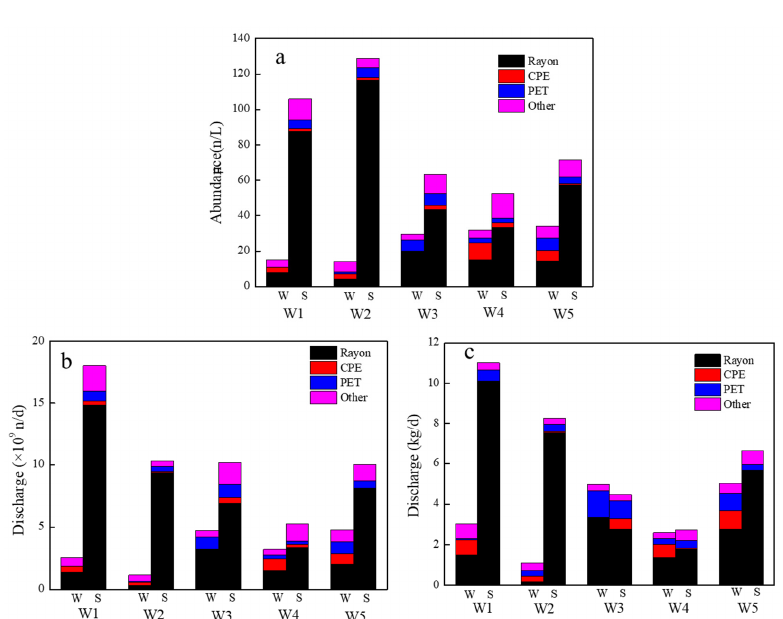
Figure 4. The abundance and emission of MPs in the effluent discharged from WWTPs in winter and summer in Qingdao, China, in which ( a ) is abundance, ( b ) emission in items/d, and ( c ) emission in kg/d. The average diameter of fibers was about 30 µm, as calculated from the 30 measured fibers, and the thickness of fragments was about 3 µm. Based on the abundance of MPs in the average size of each type of MPs, the amounts, and masses of MPs discharged into near sea area were estimated. The results are as shown in Table 1 and Figure 4. The daily discharged rayon in the effluent from the five WWTPs varied from 3.3 × 10 8 to 3.2 × 10 9 items/d, equivalent to 0.2~3.3 kg in winter. In summer, the corresponding values increased to 3.3 × 10 9 ~14.9 × 10 9 items/d (1.8~10.1 kg). The amount of the other polymer type MPs discharged in the effluent from the WWTPs varied in the range of 0.8 × 10 9 ~2.8 × 10 9 items/d (0.9~2.7 kg/d) in winter and 1.0 × 10 9 ~3.2 × 10 9 items/d (equivalent to 0.8~1.7 kg/d) in summer, with the value observed in W2 being the lowest in both winter and summer. The daily discharge of rayon can reach about 8.4 × 10 9 ~4.25 × 10 10 items from the five WWTPs, which is equivalent to 9.2~27.8 kg rayon in mass. The values for the other poly- mer type MPs ranged from 8.0 × 10 9 ~11.2 × 10 9 items, corresponding to 7.6~5.3 kg MPs in mass. Considering the resident population in the urban area of Qingdao was 2.74 million in 2019, the rayon per capita daily emission was estimated to be 3.1 × 10 3 ~1.6 × 10 4 items/d corresponding to 3.3 × 10 − 3 ~1.0 × 10 − 2 g, and the per capita daily emission of the other pol- ymer type MPs varied between 2.9 × 10 3 ~4.1 × 10 3 items, which is equal to 2.8 × 10 − 3 ~1.9 × 10 − 3 g. 4. Discussion 4.1. Characteristics of MPs in the Effluent of WWTPs in Different Regions The various sources and treatment processes of wastewater in WWTPs in different regions may cause discrepancies in the characteristics of MPs in WWTPs. Table 2 shows the characteristics of MPs in the effluent from WWTPs in different regions. It can be seen